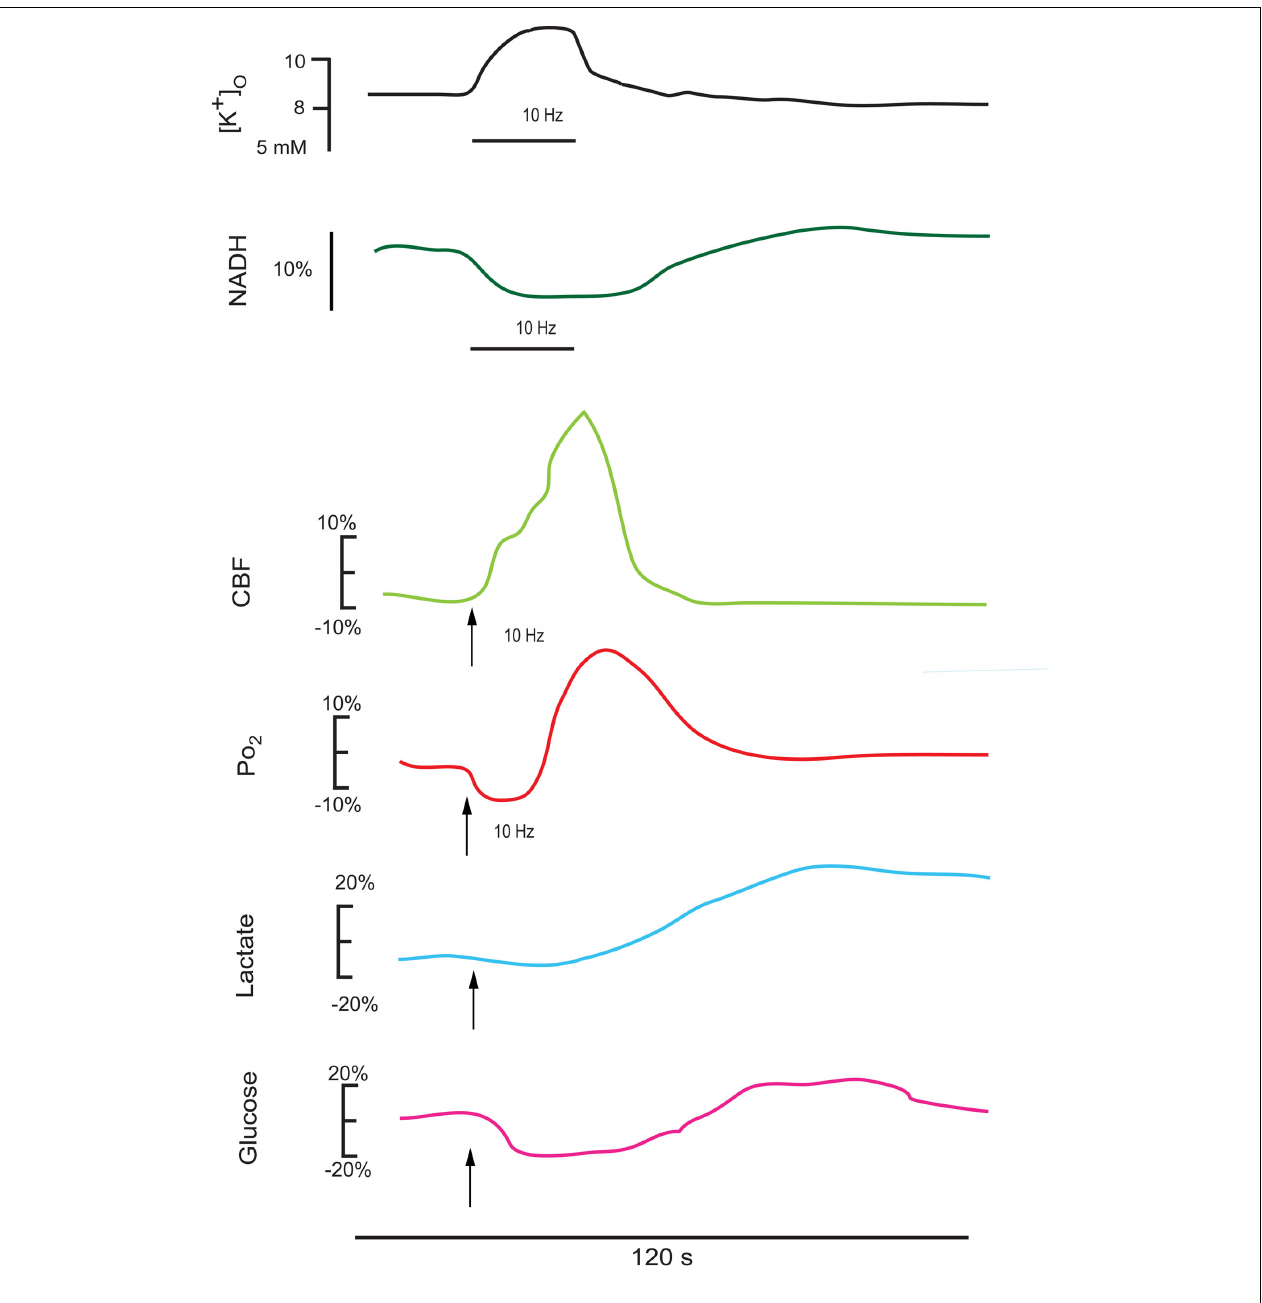
FIGURE 2 |This series of redrawn and rescaled traces show measured responses in vivo from intact brain (though different structures), where changes in cerebral blood flow can alter the basic responses to a stimulation train. The upper K + and NADH traces are in response to a 25-s stimulus train at 10Hz in the cortex (Lothman et al., 1975), showing a consistent K + elevation and an NADH oxidation (Turner et al., 2007).The CBF and PO 2 responses follow a 15-s stimulation train at 10Hz in the